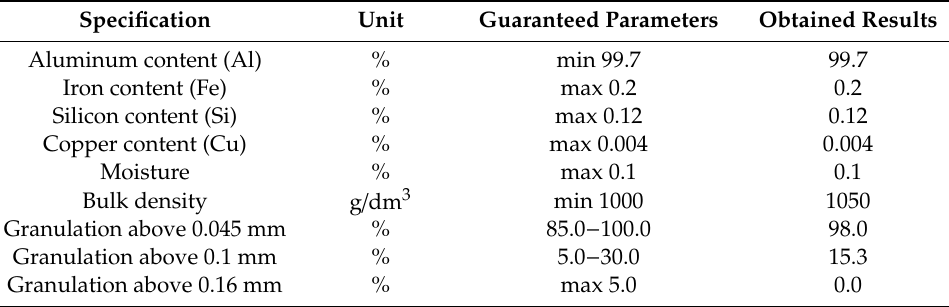
Table 1. Specification of aluminum powder EN AW 1000